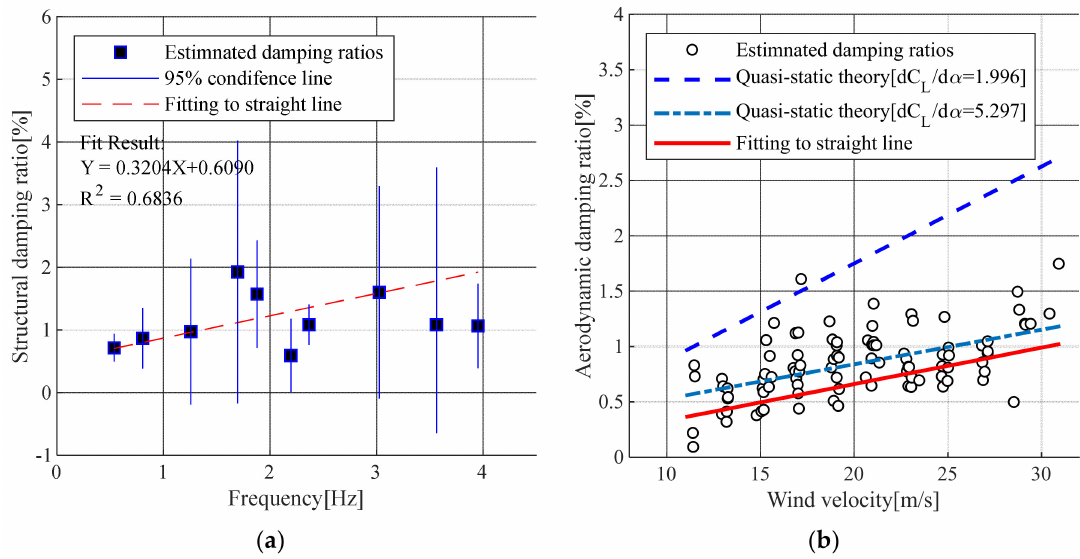
Figure 6. Estimated damping ratios: ( a ) Structural damping ratios of vertical bending modes; ( b ) Aerodynamic damping ratios of the first vertical